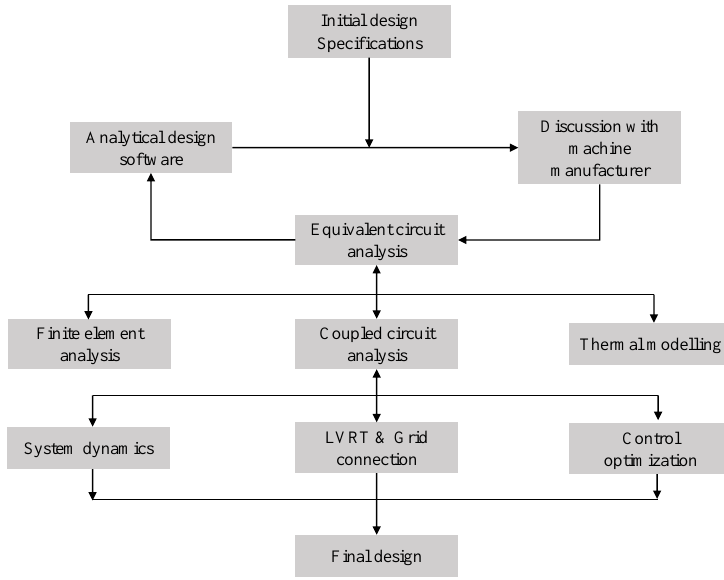
Figure 12. Proposed design procedure for a 6-MW BDFM